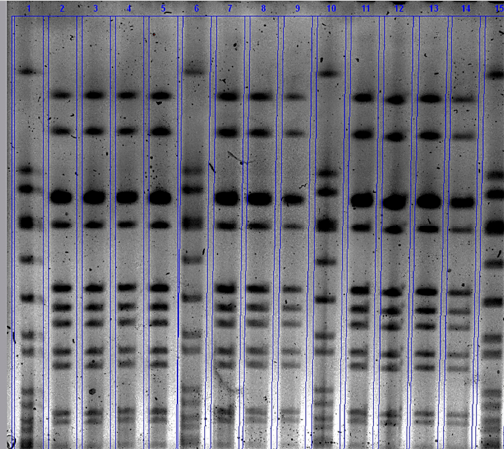
Figure 4. Banding patterns obtained from SmaI digested DNA and pulsed field gel electrophoresis (PFGE) of S. aureus strains isolated from mammary secretion from left rear of 4398 cow during challenge period. Lanes 1, 6,10 and 15: S. aureus strain NCTC8325 (internal control strain for PFGE analysis); Lanes 2 and 14: S. aureus challenge strain UT2; Lines 3, 4, 5, 7, 8, 9, 11, 12 and 13: S. aureus isolates identified on day 1, 2, 3, 4, 5, 6, 7, 10 and 14, respectively. 3.3. Systemic Immunological Responses of Dairy Cows against S. Aureus Intramammary Infection There were high background anti- S. aureus IgG titers in both control and experimental cows prior to experimental infection. Infection by S. aureus induced a slight increase in serum anti- S. aureus IgG titers at days 7 and 14 of the challenge but not significantly different from non-infected control cows (Figure 5).